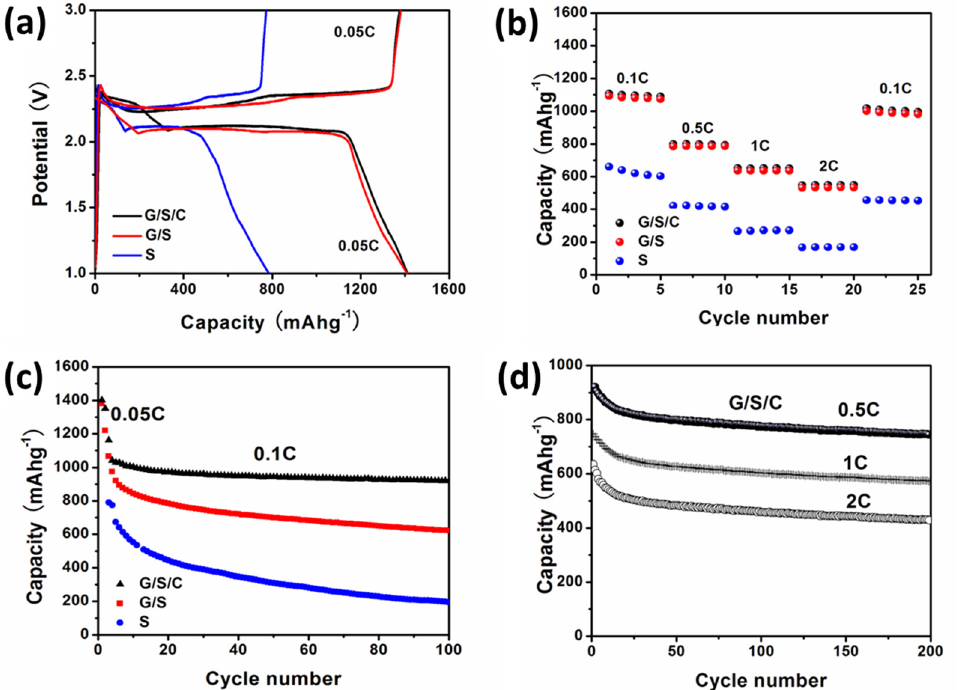
Figure 7. ( a ) Galvanostatic discharge/charge profiles at 0.1 C rate of cells using G/S/C,